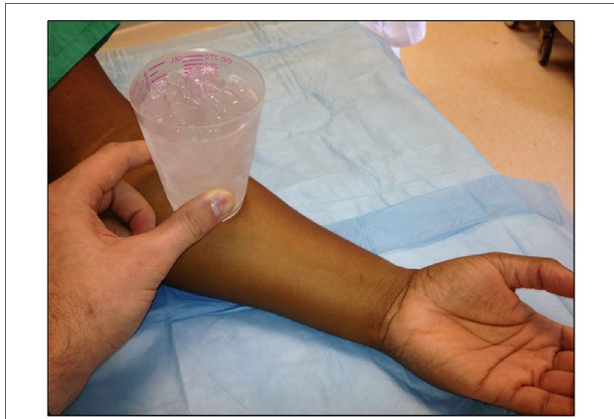
FIgURe 1 | A cold stimulus (0–4°C) is placed on the forearm for 5 min. The presence of an immediate coalescent wheal is indicative of cold-induced